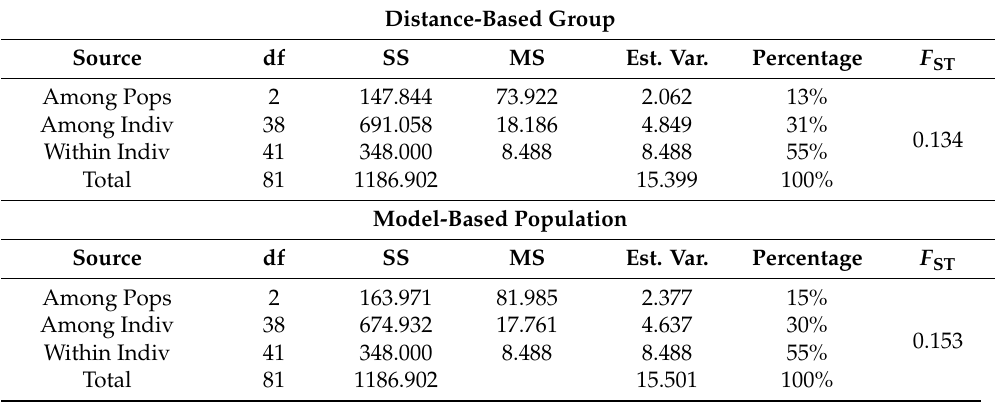
Table 4. AMOVA analysis of distance- and model-based clustering.